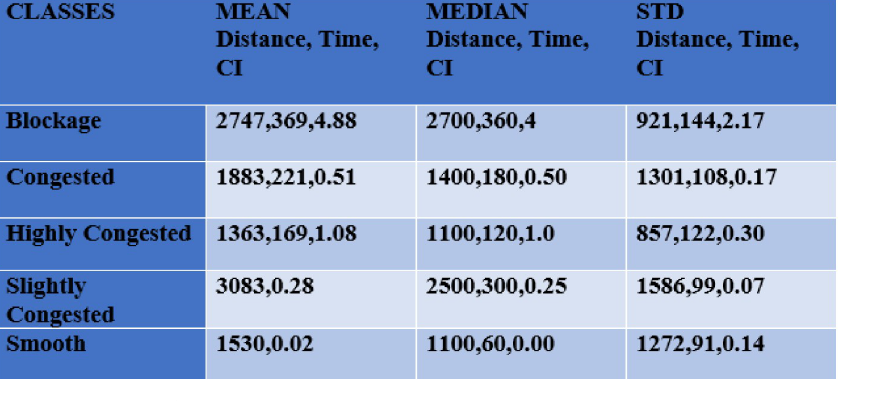
Fig 3. Descriptive analysis.